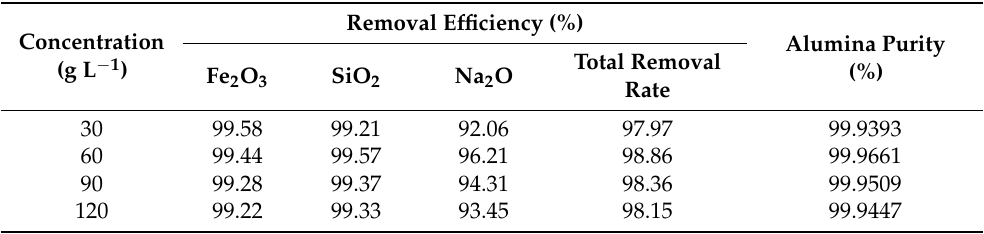
Table 3. Influence of initial NaAl(OH) 4 solution concentration on impurity removal efficiency and alumina